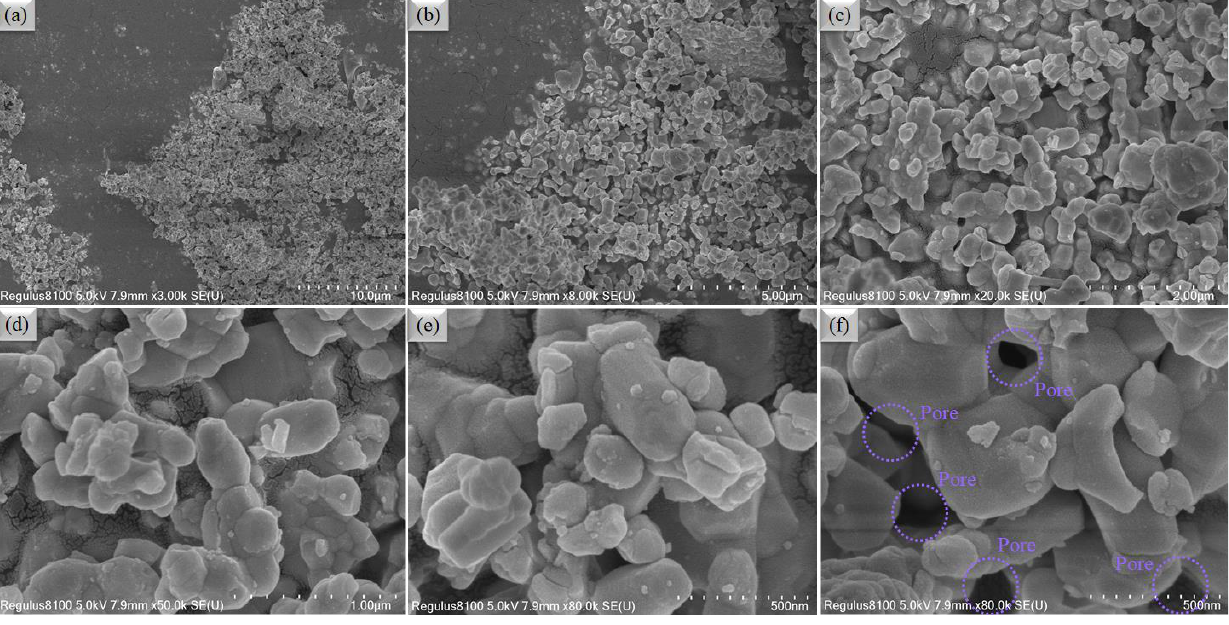
Figure 2. ( a , b, c d, e and f ) The surface morphology studied by SEM for LaFe 0.8 Gd 0.1 Ce 0.1 O 3- δ powder at different scale of 10 – 500nm.